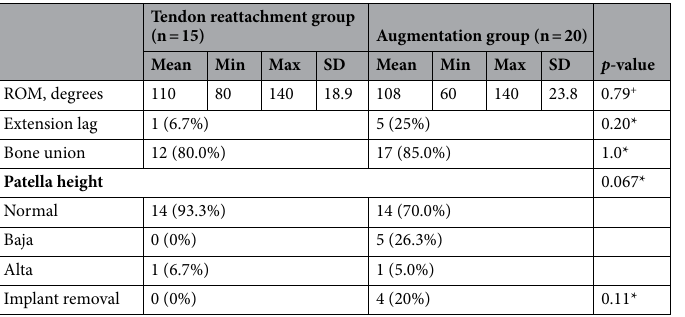
Table 2. Descriptive table of outcome variables. ROM range of motion. + Mann–Whitney U test. *Fisher’s exact